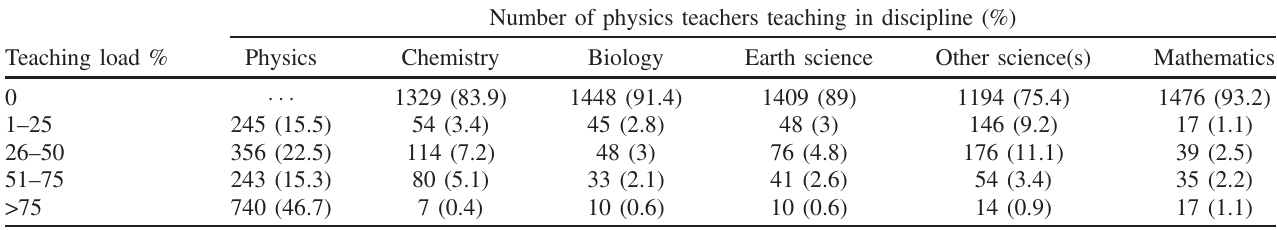
TABLE VI. Course load of all physics teachers ( N ¼ 1584 ).